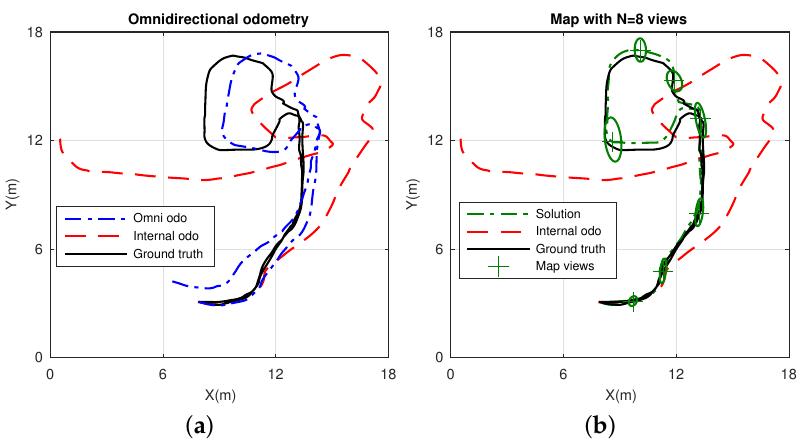
Figure 22. SLAM results in Dataset 3. ( a ) estimated omnidirectional visual odometry, drawn in dash-dotted line, ground truth in continuous line and internal odometry in dashed line; ( b ) estimated SLAM solution, in dash-dotted line, when the prior input is the omnidirectional visual odometry shown in ( a ). Again, the ground truth and internal odometry are also presented. The final map is constituted by N = 8 views, with their associated uncertainty ellipses.